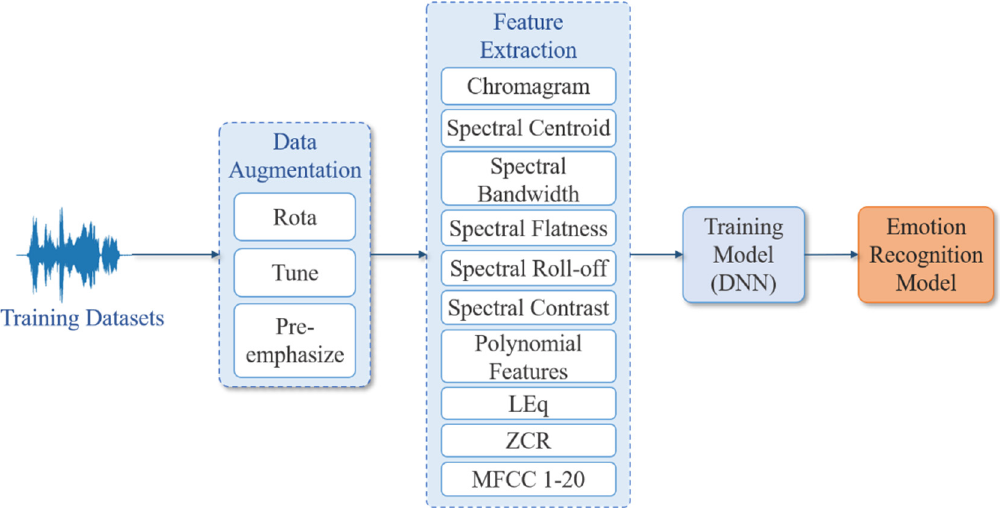
Figure 3. Training flowchart of the proposed emotion recognition model.